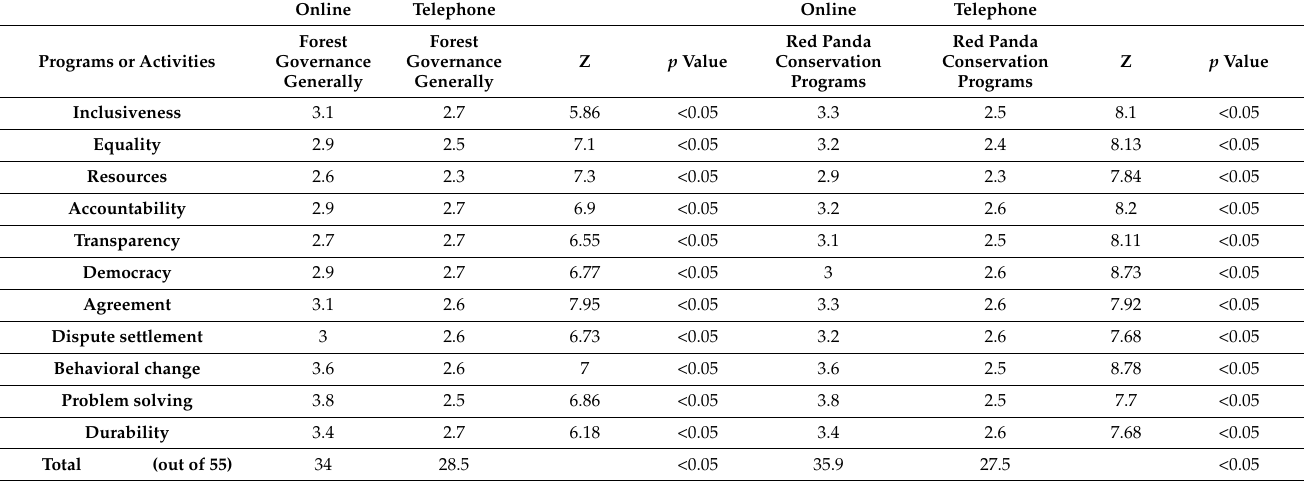
Table 5. Comparison between the perceptions of online and telephone survey respondents to forest governance and red panda conservation programs (August–September 2020)